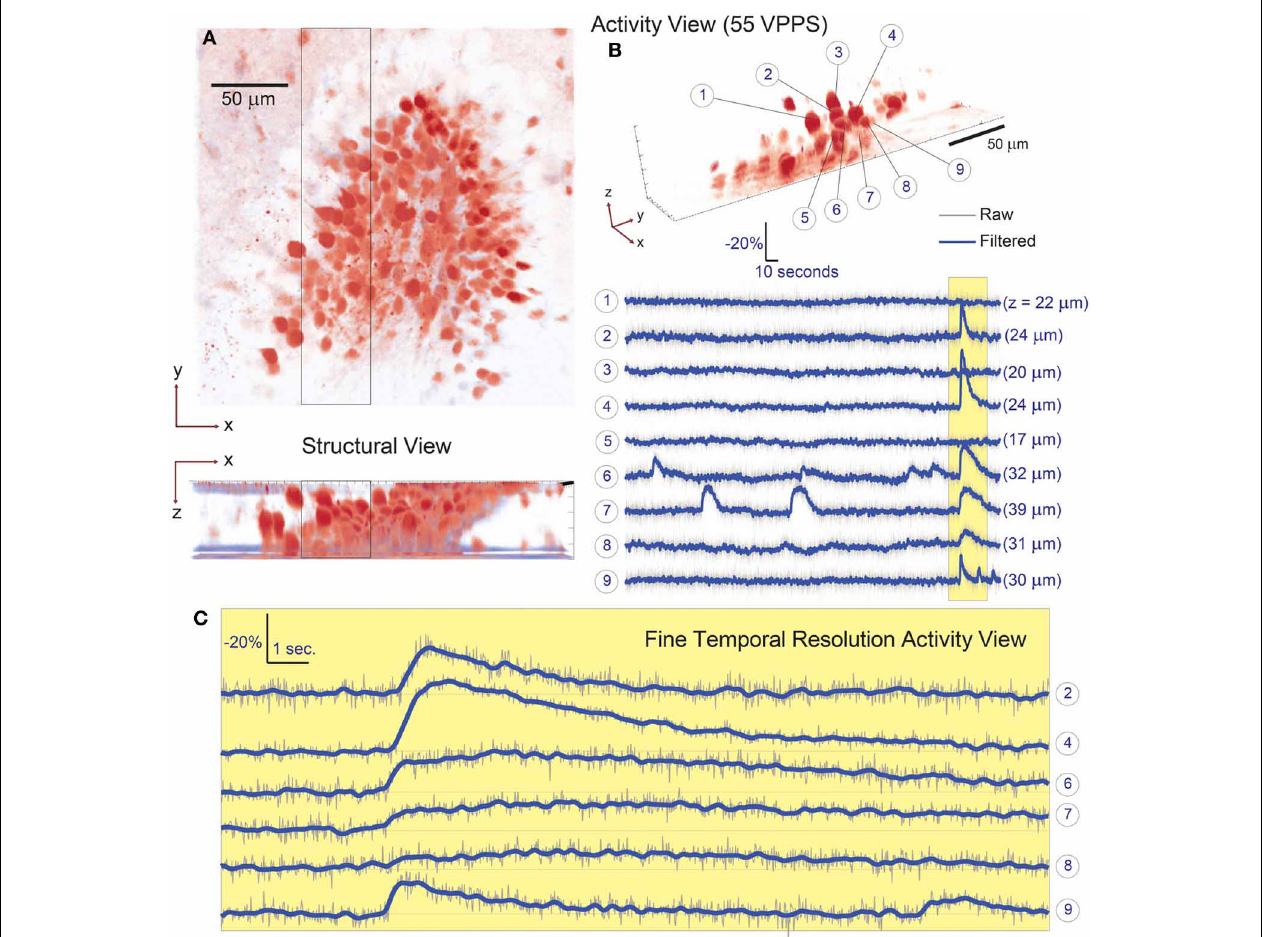
FIGURE 3 | Simultaneous 3D imaging of hippocampal neuronal activity in vitro at 55 volume projections per second. (A) 3D structural data acquired by two-photon raster-scanning image stack. (B) 3D functional imaging with single cell resolution, where 9 of 107 total cells are selected from the 3D volume [boxed region of (A) ] and their respective activity is given